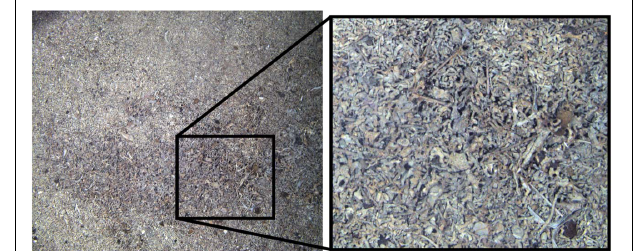
FIGURE 3 | A SUCS image of seabed around Ascension Island’s coast showing extensive build-up of carbonate from dead coral, echinoid echinoderms, sponges, mollusks, and